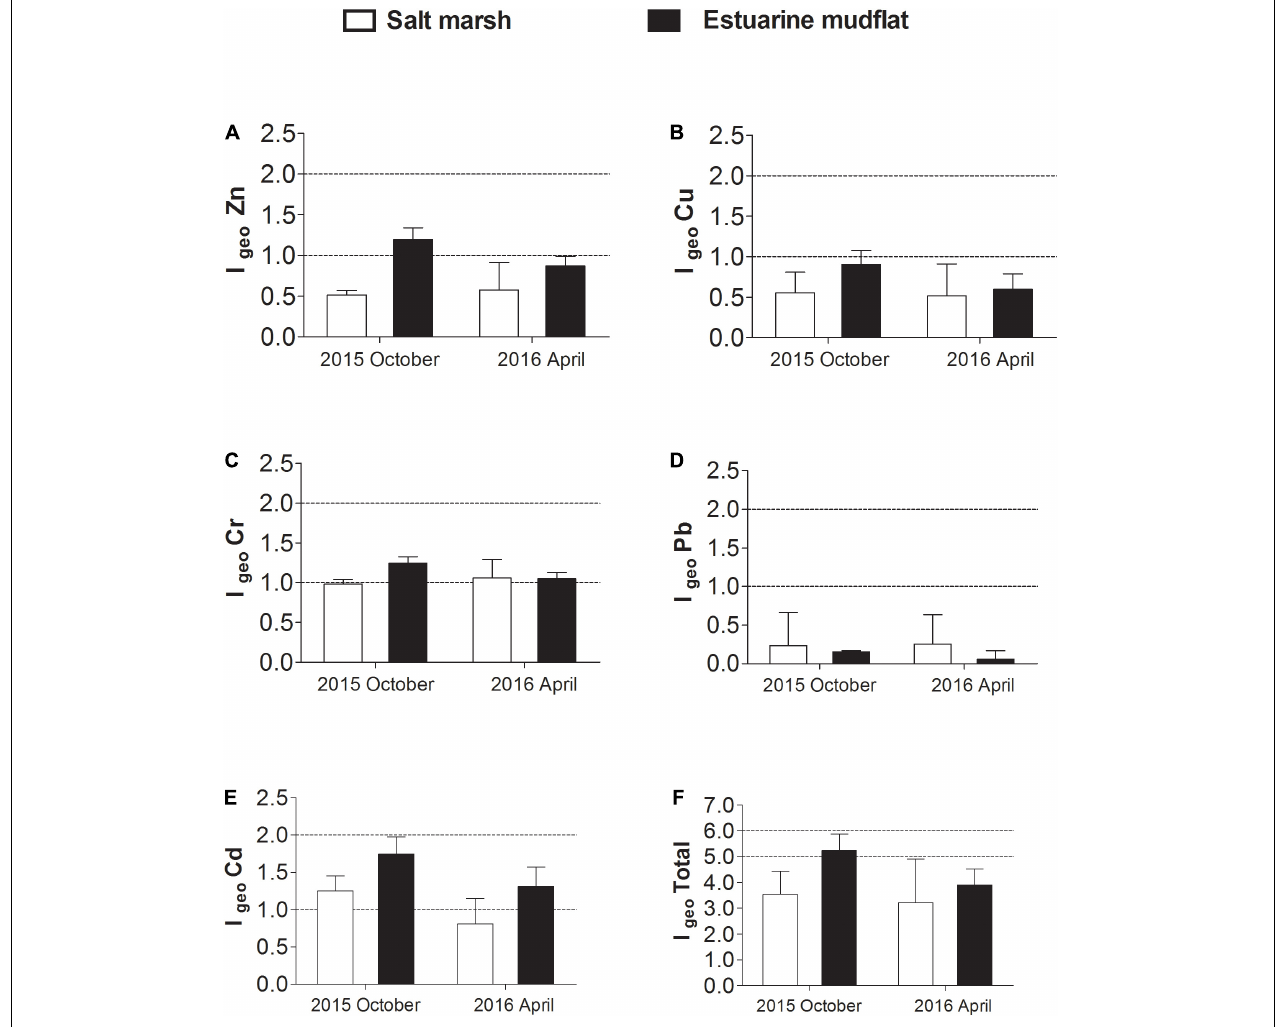
FIGURE 3 | Geo-accumulation indices (I geo ) of heavy metals (A) Zn, (B) Cu, (C) Cr, (D) Pb, (E) Cd and their (F) I geo total of measured heavy metals in the estuarine mudflat (WSK, SDK, and LHK) and Chongming salt marsh (BBY and DWS) sediments from the Yangtze River estuary, collected during October 2015 and April 2016. An I geo total of less than 5 represents Class I, weakly polluted; an I geo total between 5 and 10 represents Class II, moderately polluted.